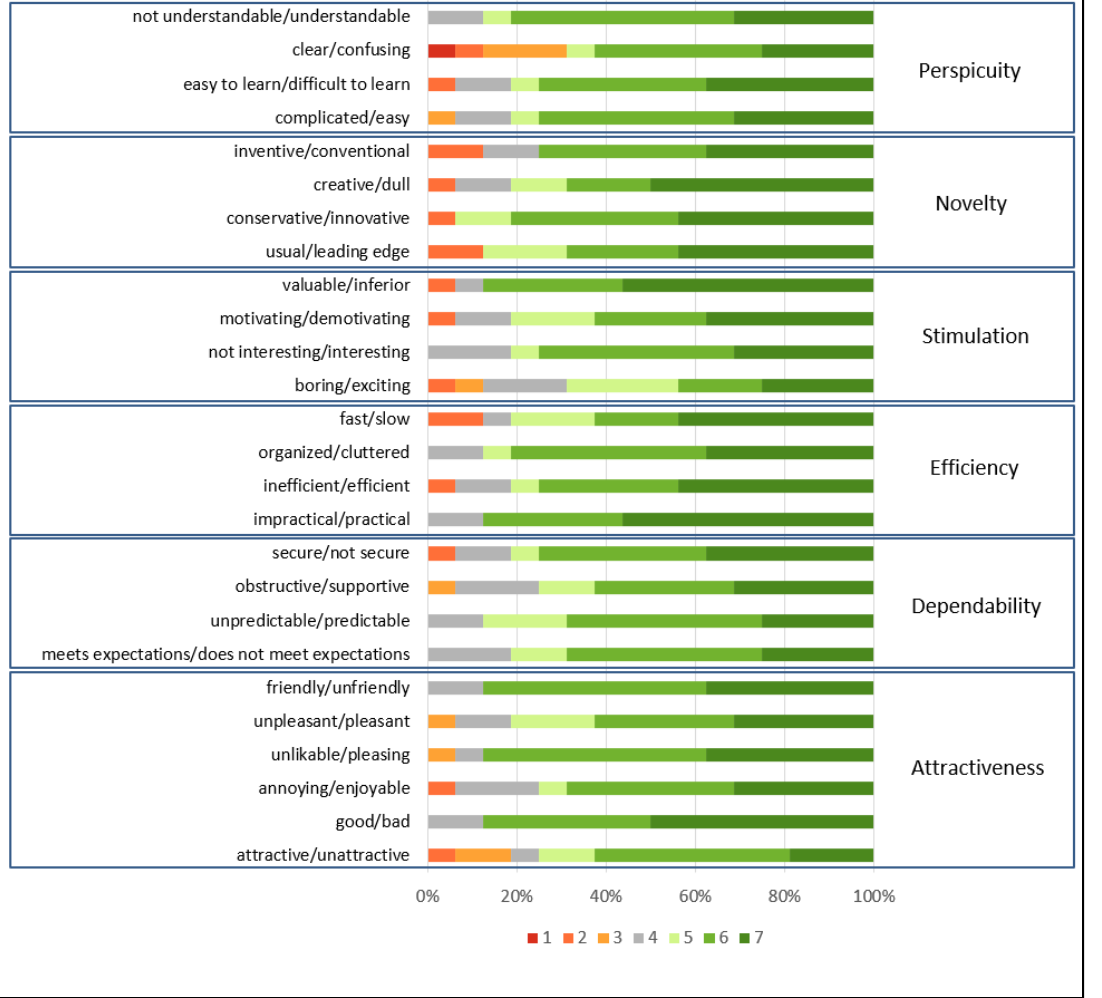
Figure 6. Answers’ distribution graphic generated by data analysis tool provided by UEQ grouped by scales [28].